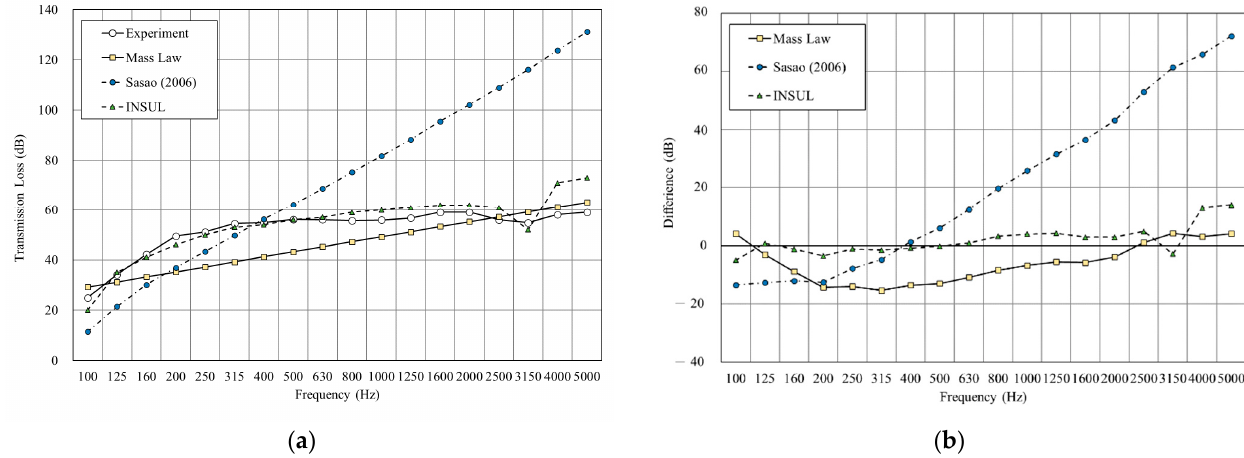
Figure 20. Comparison between experimental and predicted results of CLT + GB with 50 mm glass wool (C4). ( a ) The sound insulation performance of experiment and prediction. ( b ) The RMSE results of different prediction models.